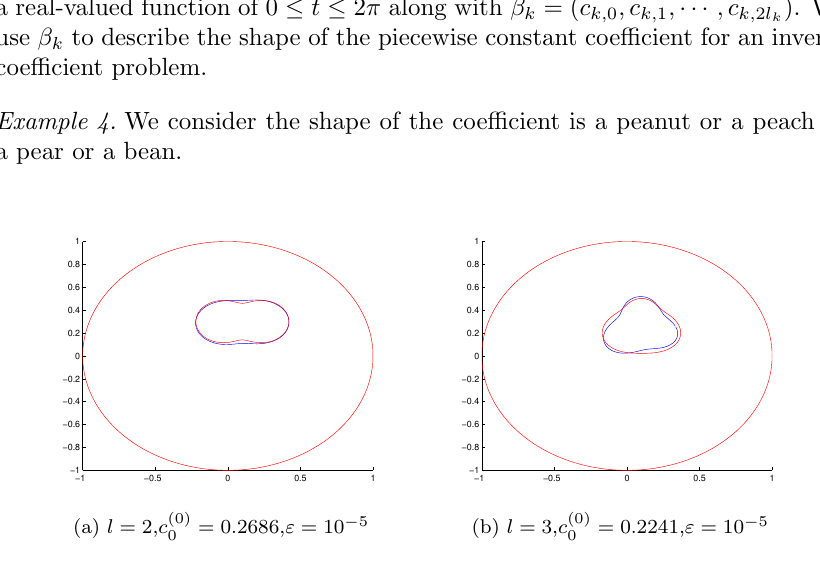
Figure 6. (a) Peanut; (b) peach. Apply TRA to reconstruct the shape of the coefficient with the accurate data along with exact solution (red) and recovered solution (blue), respectively for Example